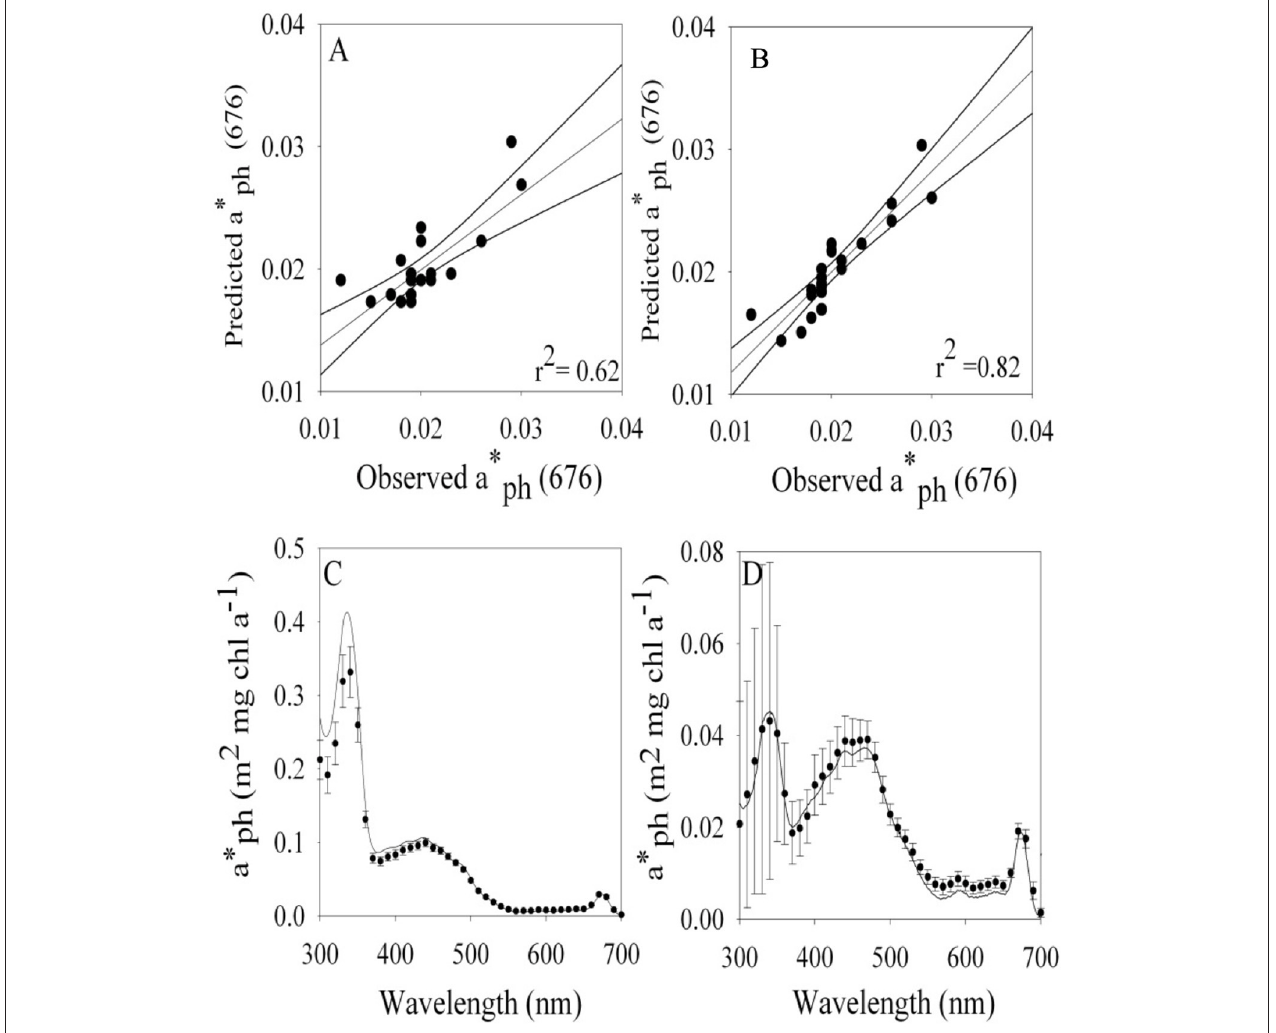
FIGURE 3 | Modeled vs. observed values of a* ph at 676nm based on a linear regression using (A) light and (B) a multiple linear regression based on temperature and light. Comparison of a* ph ( λ ) observed (1nm resolution continuous line) vs. modeled values (10nm resolution) based on temperature and light for cultures grown at (C) 4 ◦ C 542 µ mol quanta m − 2 s − 1 and − 1.5 ◦ C and (D) 37 µ mol quanta m − 2 s − 1 . Note scale difference in a* ph in (C,D) . Standard error bars are shown for model estimates. Figure 5B . This fit resulted in a single value of µ m and α for the full data set in Figure 5B that we used to estimate a generalized value of E k µ ( µ m / α ) for Phaeocystis spp. This resulted in a E k µ value of 110 µ mol quanta m − 2 s − 1 overall fit with r 2 =